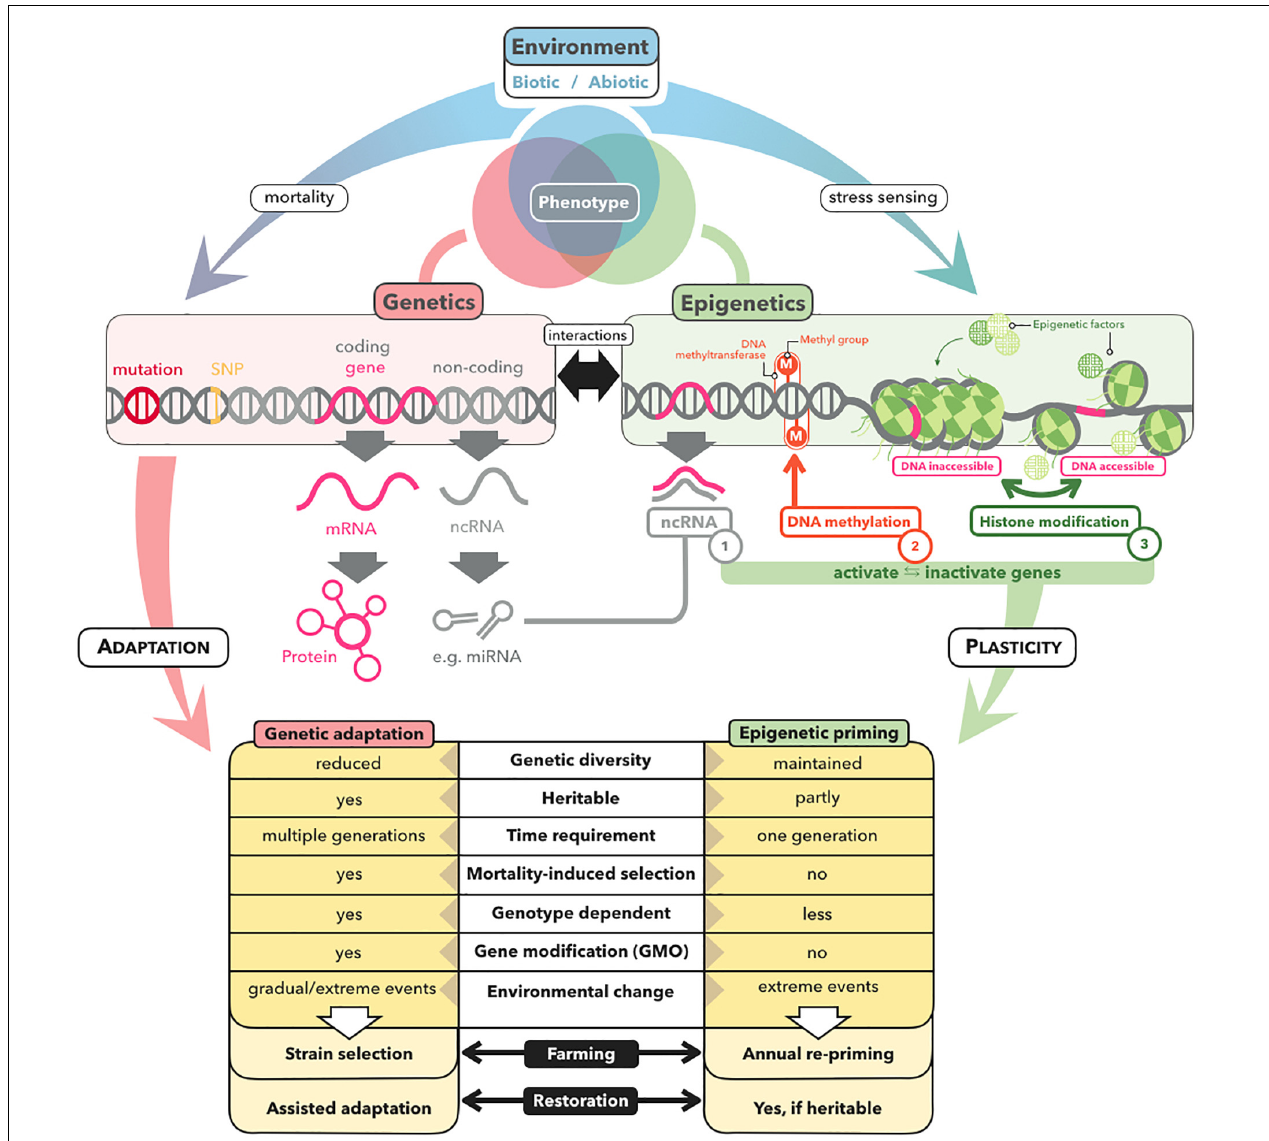
FIGURE 2 | Genetic versus epigenetic mechanisms underlying stress adaptation and their relevance for restoration and farming of marine macrophytes. Environmental stress can alter the phenotype of marine macrophytes by positive selection of pre-adapted genotypes or of new beneficial mutations, resulting in genetic adaptation of the population within several generations. In contrast, epigenetic mechanisms, comprising ncRNAs, DNA methylation, and histone modifications, contribute to phenotypic plasticity by altering the expression patterns of genes within a single generation. The key characteristics with respect to the application potential of genetic and epigenetic mechanisms for farming and restoration of marine macrophytes, are listed at the